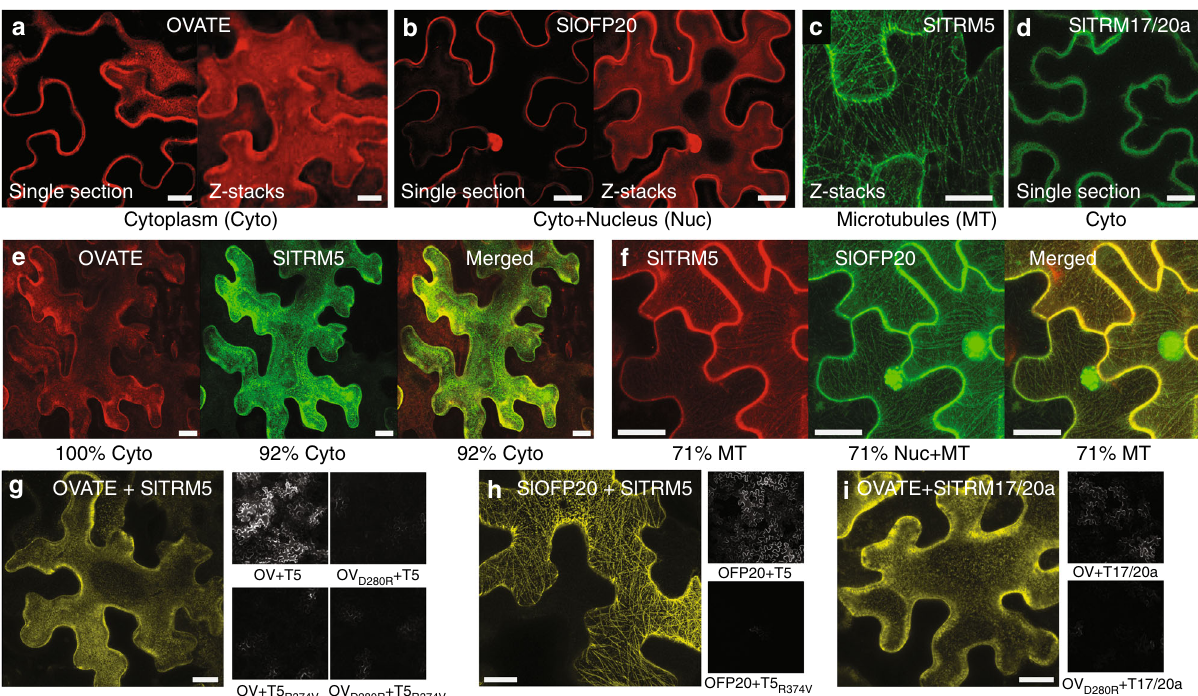
Fig. 3 Interactions of SlOFPs and SlTRMs in N. benthamiana leaf epidermal cells. a – d Subcellular localization of OVATE, SlOFP20, SlTRM5, SlTRM17/20a, respectively. e Co-expression of OVATE and SlTRM5. f Co-expression SlOFP20 and SlTRM5. g – i BiFC with wild-type and mutant versions of SlOFPs and SlTRMs. On the left, an image of a single cell at 40× magni fi cation demonstrating the subcellular localization of the interacting proteins. Black and white images on the right, an overview of signal intensity at 10× magni fi cation. Scale bar, 20 μ